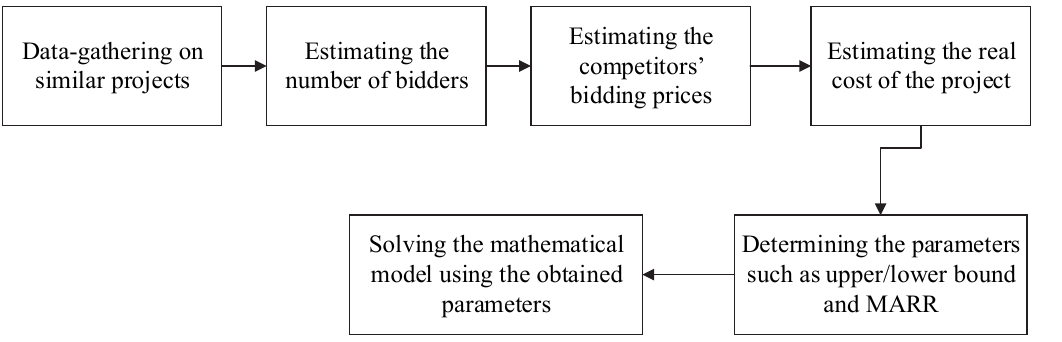
Fig. 6. Steps of calculating the bidding price in the proposed